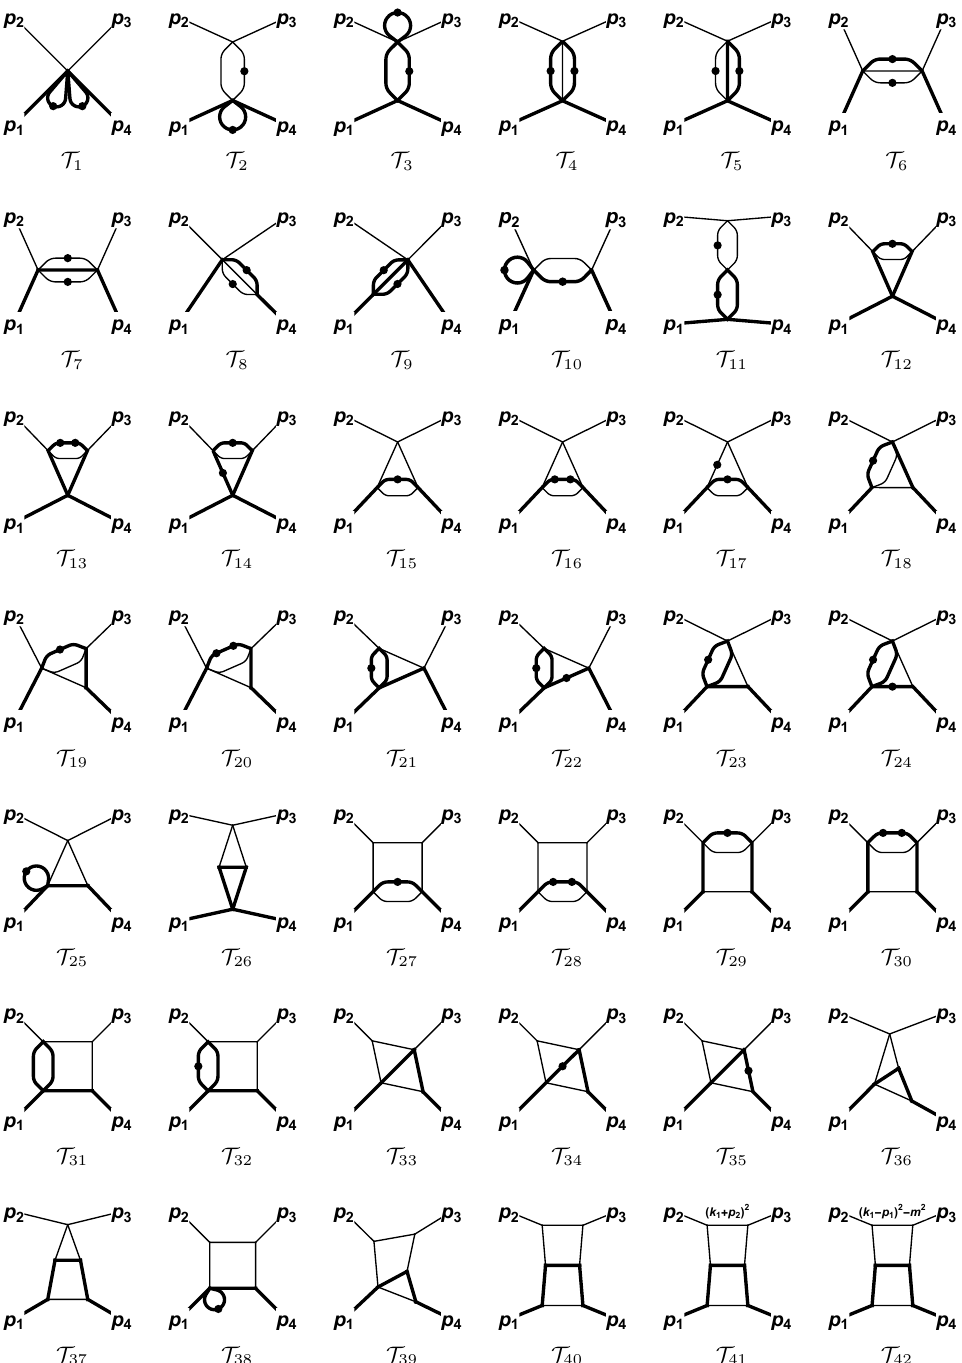
Figure 5. Two-loop MIs T